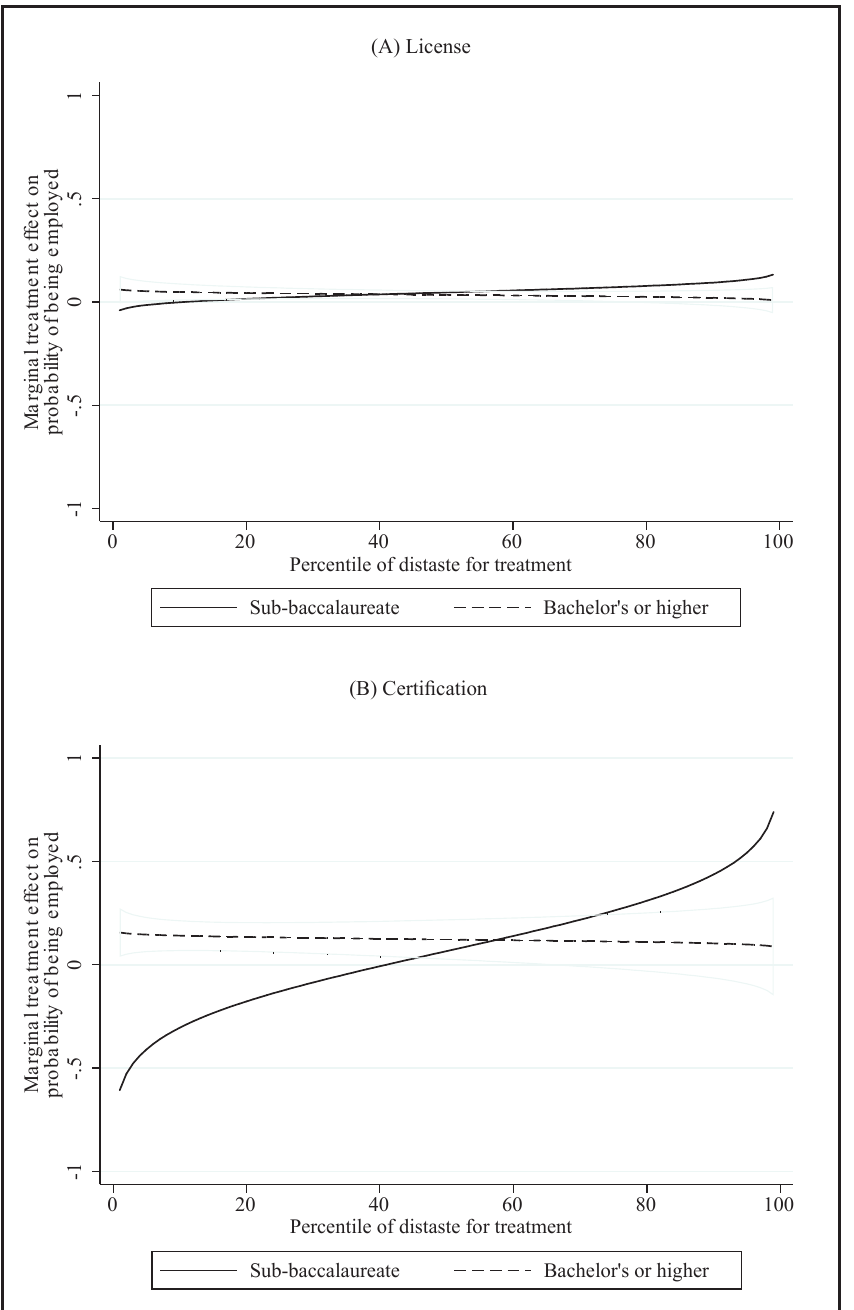
Figure 2 MTEs of credential-holding for the probability of being employed, conditional on being in the labor force.